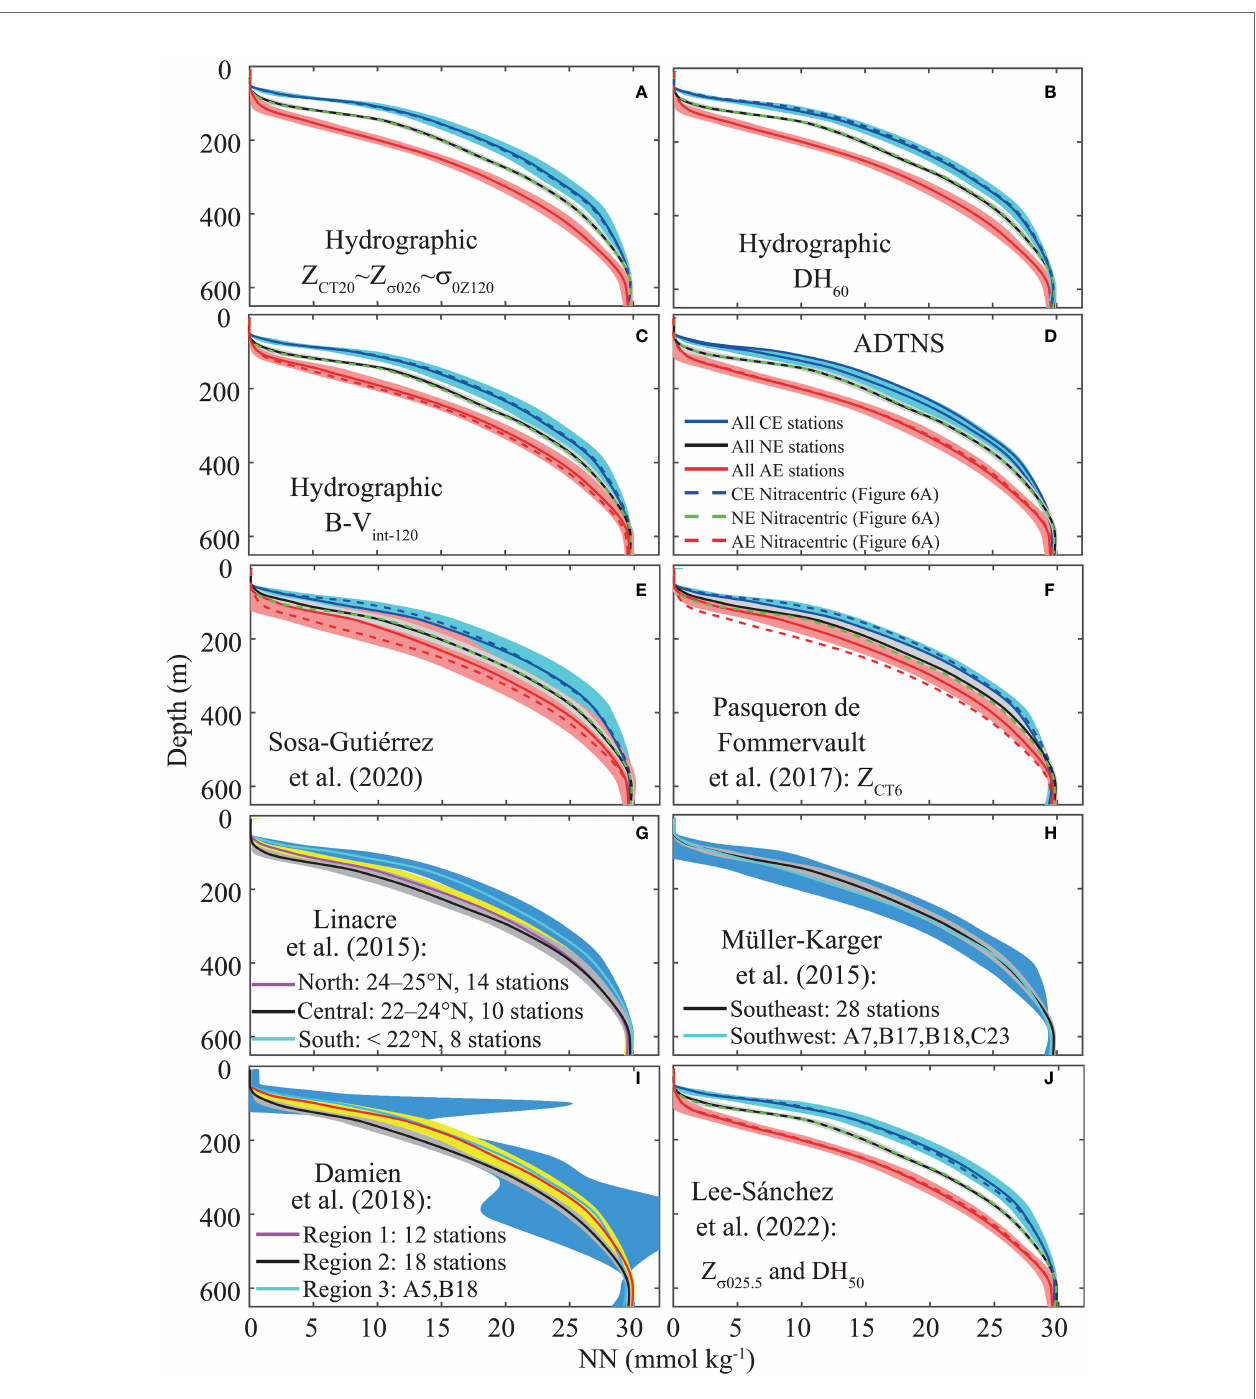
FIGURE 9 | Average of the nitrate + nitrite (NN, µmol kg -1 ) depth pro fi les with 95% con fi dence intervals (CIs) for cyclonic (CE; light blue), no eddy (NE; black), and anticyclonic (AE; red) groups obtained by (A – C) the hydrographic classi fi cation and (D) non-steric absolute dynamic topography (ADT NS , cm). (E, F) Average NN (µmol kg -1 ) pro fi les with CIs for the classi fi cation of mesoscale eddies based on the eddy identi fi cation criteria used by Sosa-Gutie ́ rrez et al. (2020) and Pasqueron de Fommervault et al. (2017), respectively. (G – J) Average NN (µmol kg -1 ) pro fi les for the geographical classi fi cations reported by Linacre et al. (2015); Müller-Karger et al. (2015); Damien et al. (2018), and Lee-Sa ́ nchez et al. (2022), respectively. The color shaded areas correspond to CIs. The thick lines are the NN means for each group. The dashed lines are the means of the nitracentric classi fi cation ( Figure 6A ). The Poseidon stations were not included in the fi